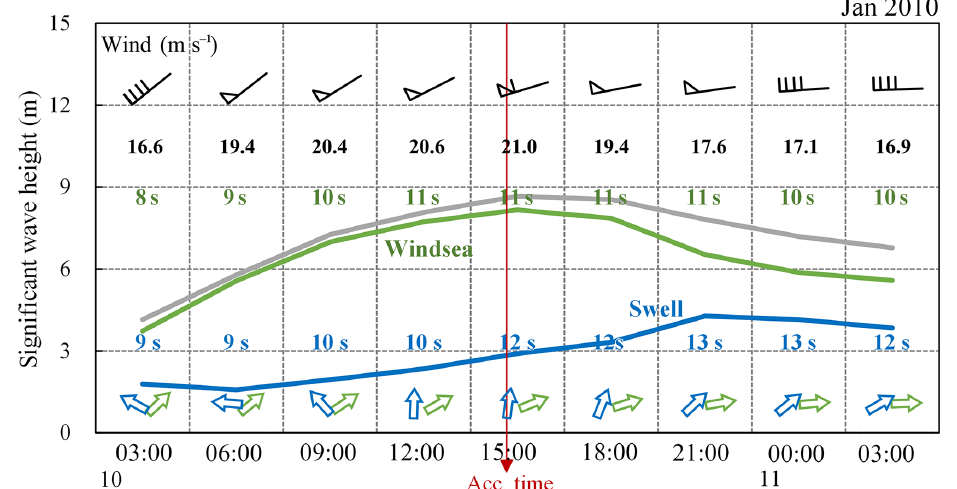
Figure 7. Time series of sea surface wind and sea state at the ship accident location over 24h for the case that occurred at 14:45UTC on 10 January 2010. The lines, symbols and numbers in the figure have the same meanings as those presented in Fig.